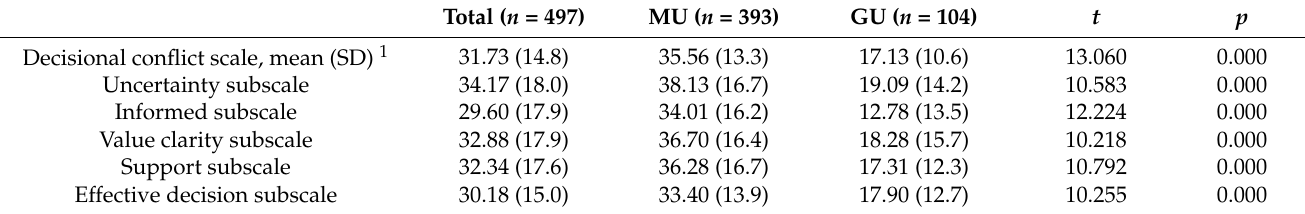
Table 4. Comparison of the mean scores on decisional conflict of the MU and GU